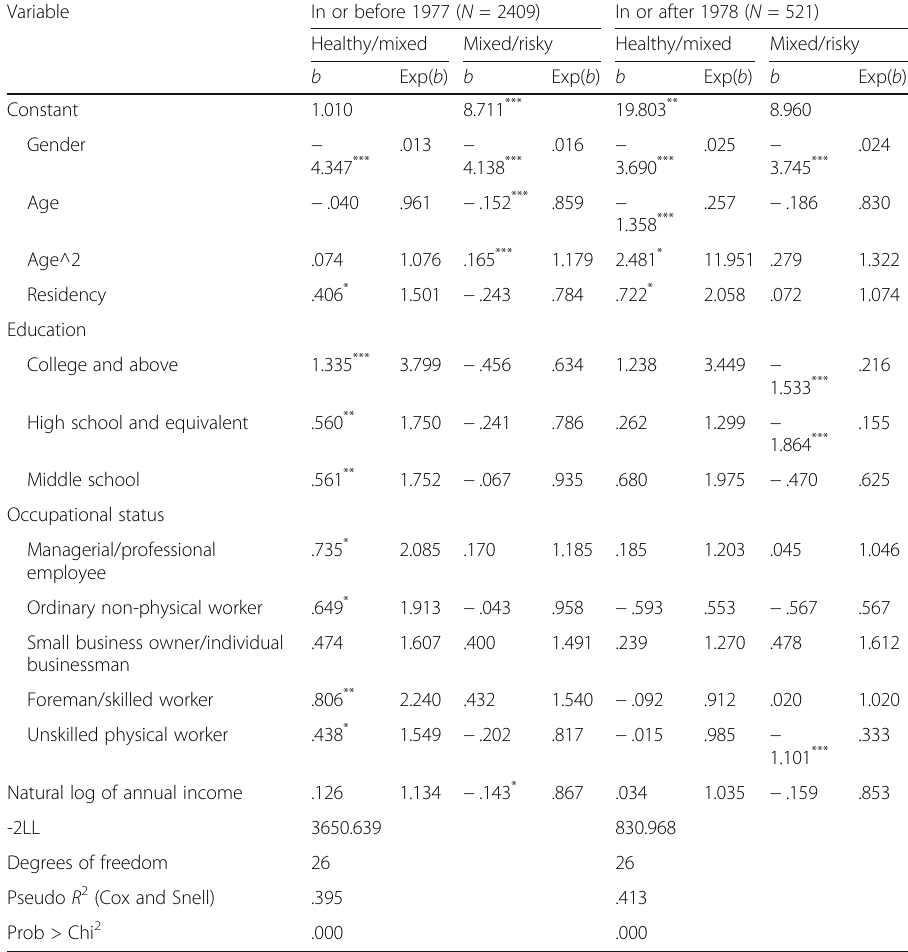
Table 5 Multivariate logistic regression of the SES-lifestyle relationship for different birth cohorts Variable In or before 1977 ( N = 2409) In or after 1978 ( N = 521)